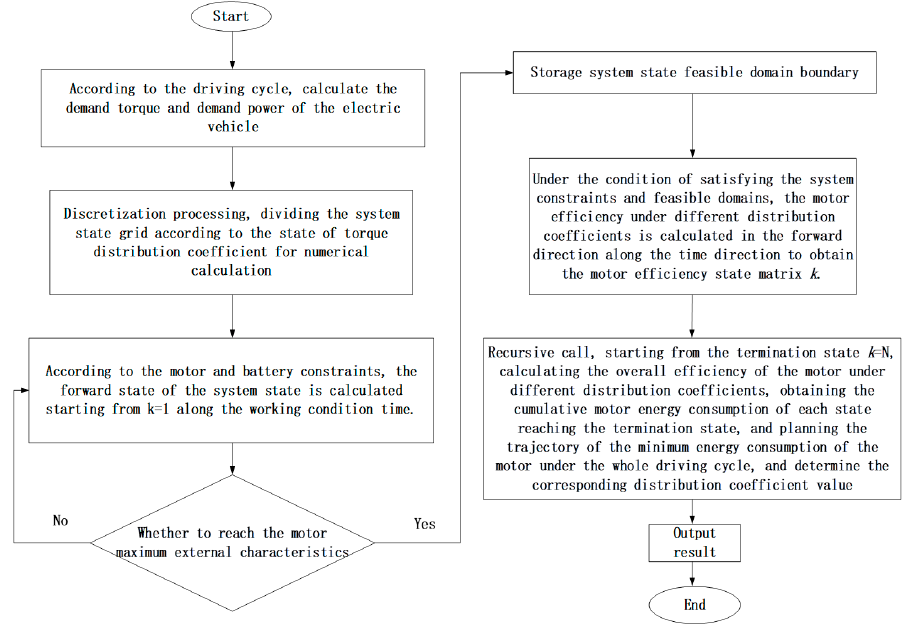
Figure 7. Dynamic planning method to achieve shaft motor torque distribution flow chart.